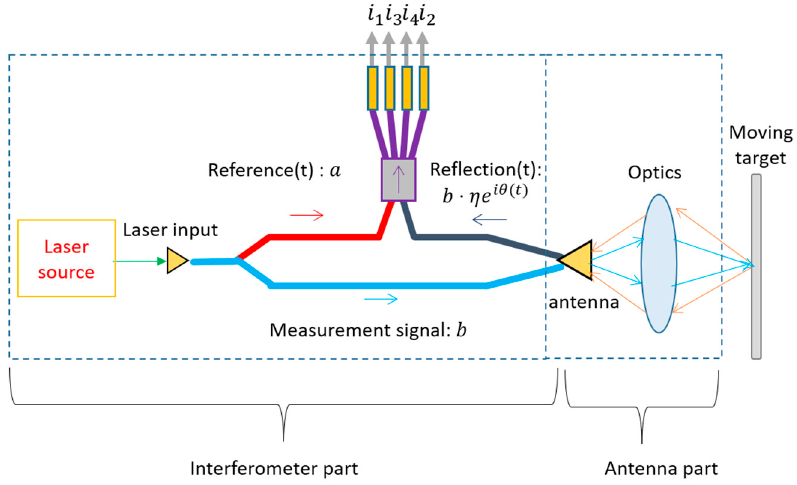
Figure 3. The two parts of the LDV sensor head.